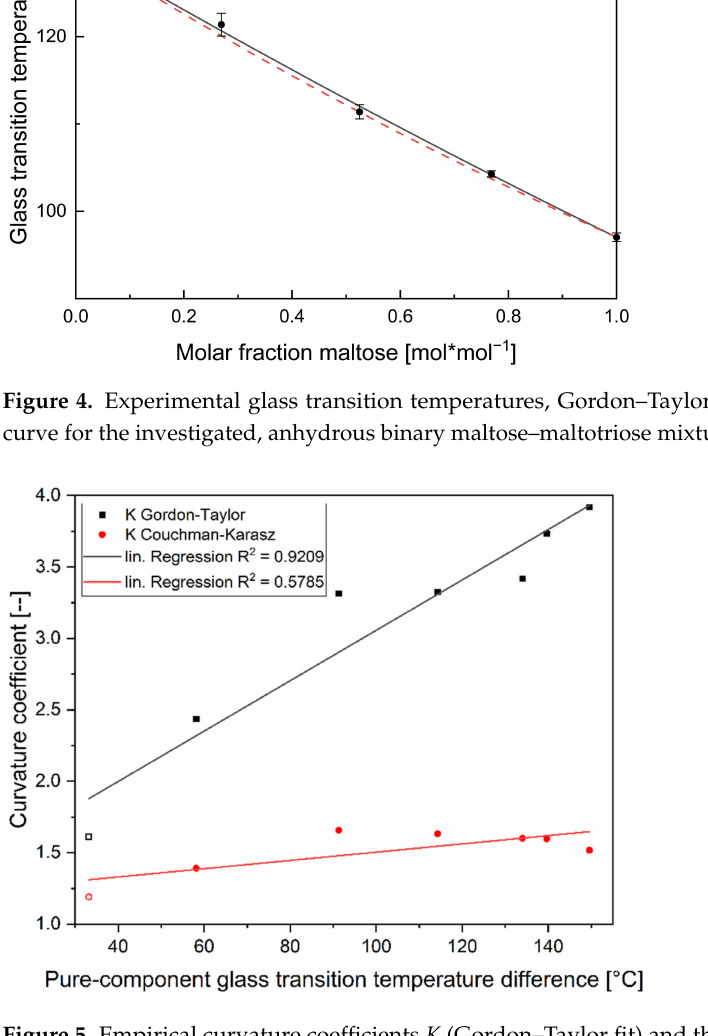
Figure 5. Empirical curvature coefficients K (Gordon–Taylor fit) and theoretical K -values (derived from the pure-component ∆ c p values) as a function of the pure-component glass transition temper- ature difference ∆ T g for the binary carbohydrate mixtures used in this study. Also included are the values of the binary maltose–maltotriose mixture from the ternary mixture design of this study (symbols without